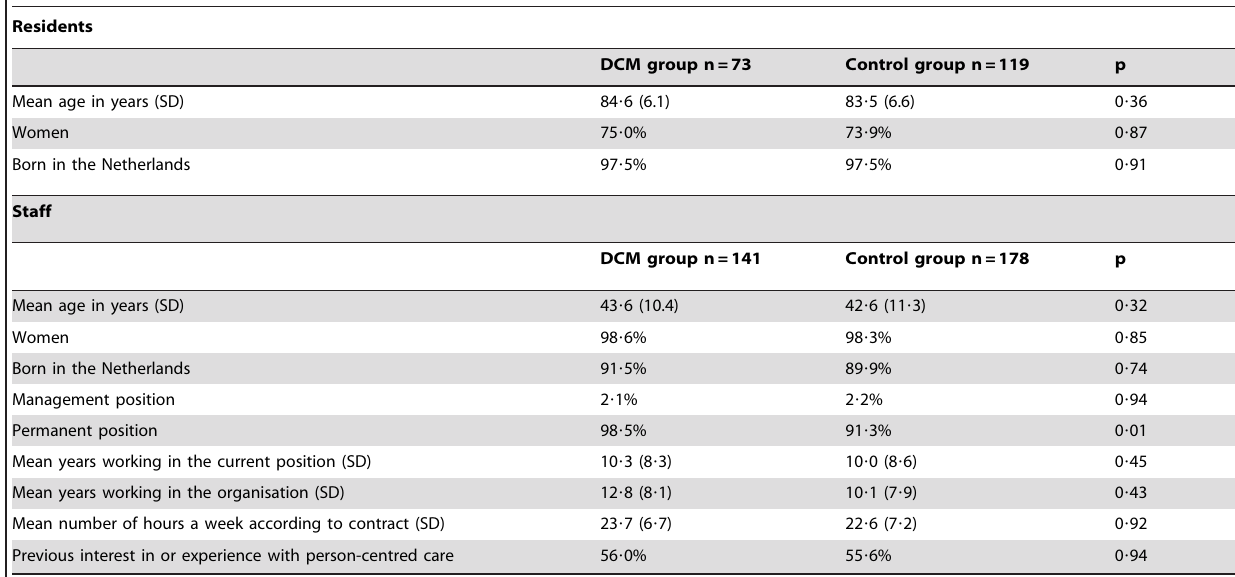
Table 1. Baseline characteristics of residents and